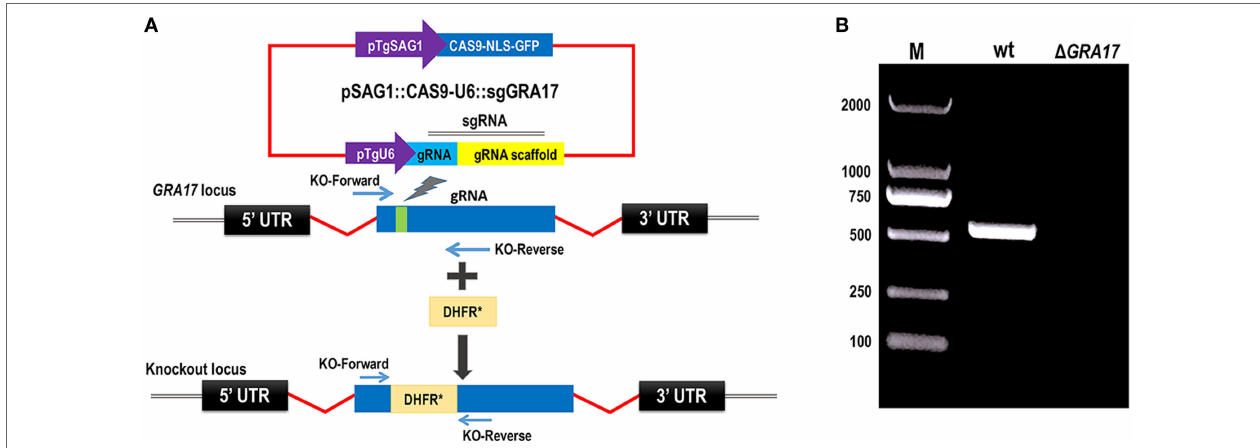
FigUre 1 | CRISPR/Cas9-mediated disruption of GRA17 gene in Toxoplasma gondii Type I RH strain. (a) Schematic representation of CRISPR-Cas9-mediated disruption of GRA17 gene by insertion of pyrimethamine-resistant DHFR* cassette into GRA17 . Transfection of pSAG1:CAS9-U6:sgGRA17 together with the DHFR* amplicon was used to disrupt the GRA17 coding region. (B) KO forward and KO reverse primers were used to amplify the small fragment. Diagnostic PCR showing DHFR* cassette integration in a representative GRA17: DHFR* clone compared with the parental wild-type RH strain (wt). M indicates the molecular weight